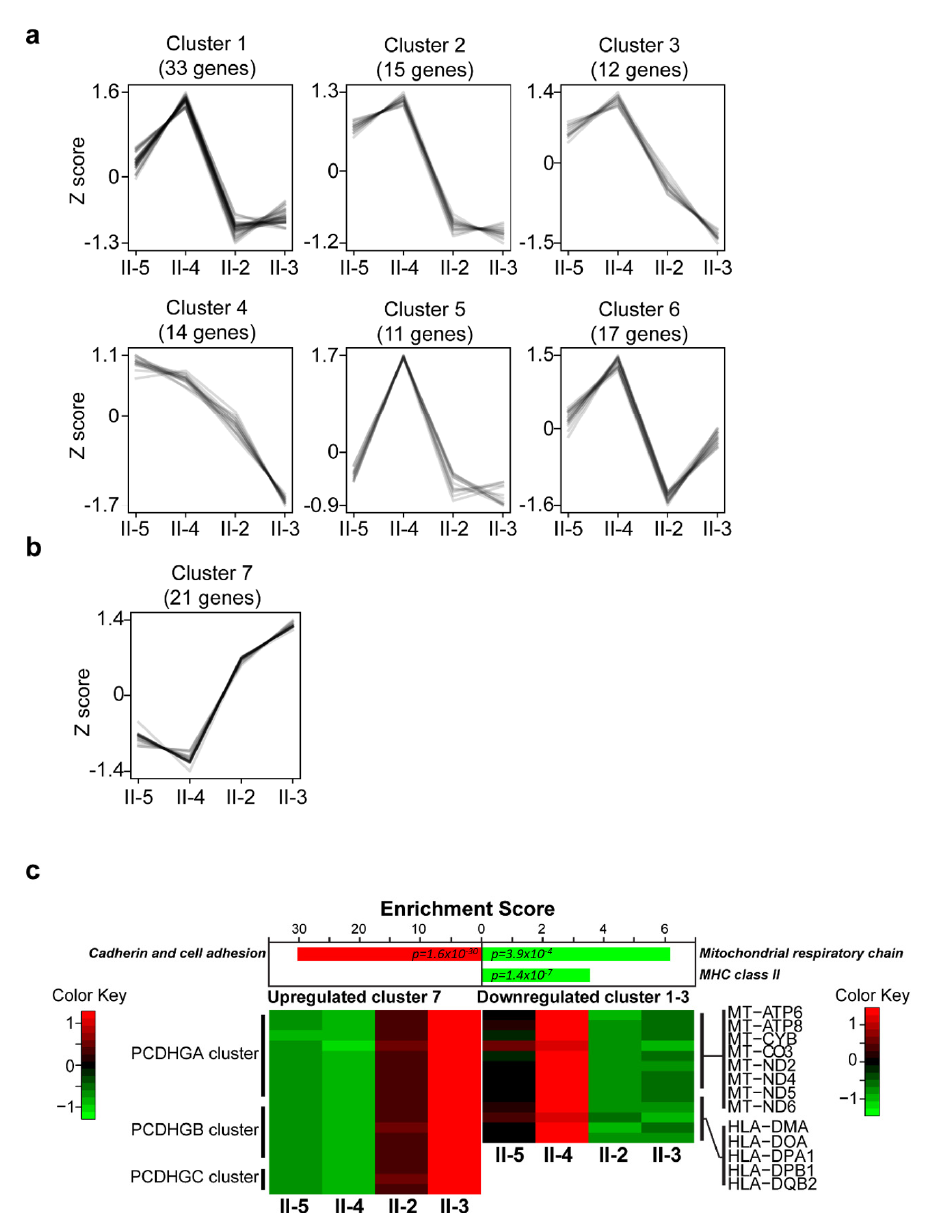
Figure 1. Clusters of expression profiles of differentially expressed genes (DEGs) and expression levels. ( a ) Six different expression clusters were obtained from downregulated genes. ( b ) One expression cluster was identified from the upregulated genes. ( c ) Expression level changes were detected in three functional groups in affected lymphoblastoid cell lines (LCLs). The expression levels of three PCDHG gene clusters ( PCDHGA , PCDHGB , and PCDHGC ) were upregulated in LCLs from affected members. Eight mitochondria-related genes and five MHC class II-related genes showed reduced expression levels in affected-members LCLs. The functional enrichment scores were obtained by using DAVID bioinformatics. Three significant functional groups with false discovery rate (FDR) < 0.05 were obtained, and the expression levels of genes within these groups are shown.